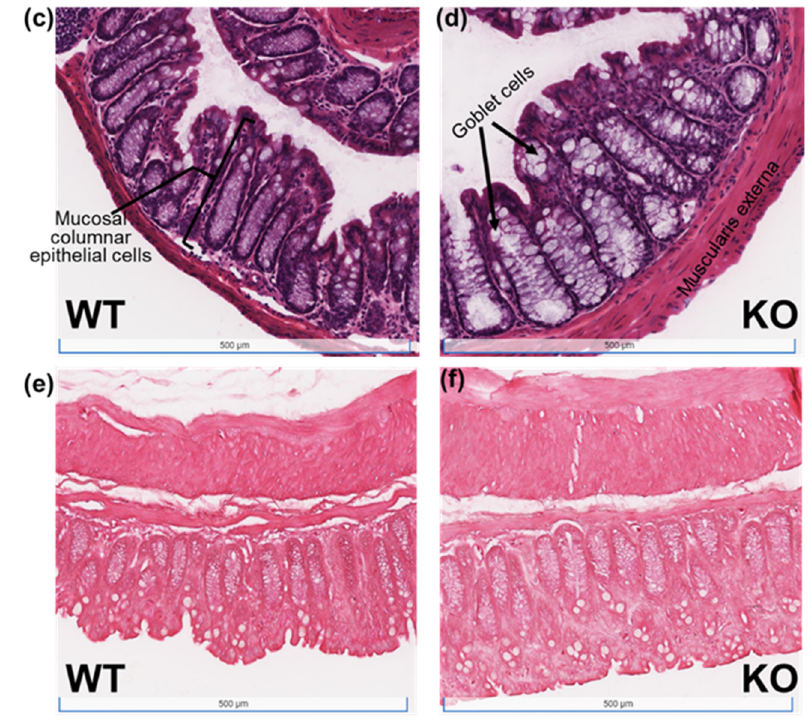
Figure 4. H&E and Masson’s Trichrome stains of colon tissues of WT and Selenof-KO animals. Tissue sections of untreated (control) WT and Selenof-KO animals maintained at adequate selenium levels were prepared with ( a – d ) hematoxylin and eosin (H&E) or ( e , f ) Masson’s Trichrome stains.